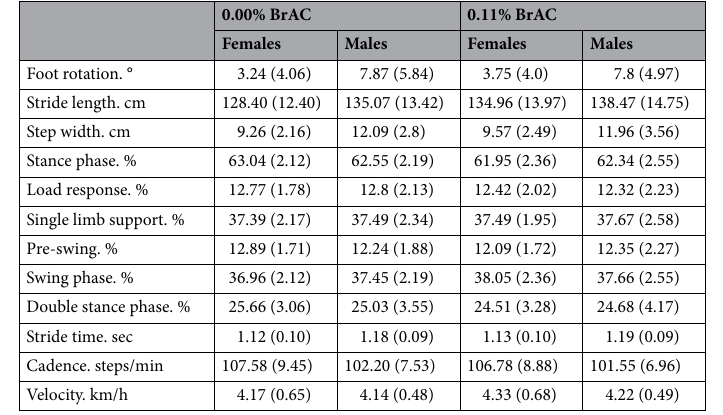
Table 5. Forward gait at a BrAC of 0.00% and 0.11% in females and males. Descriptive data are presented as mean and standard deviation.